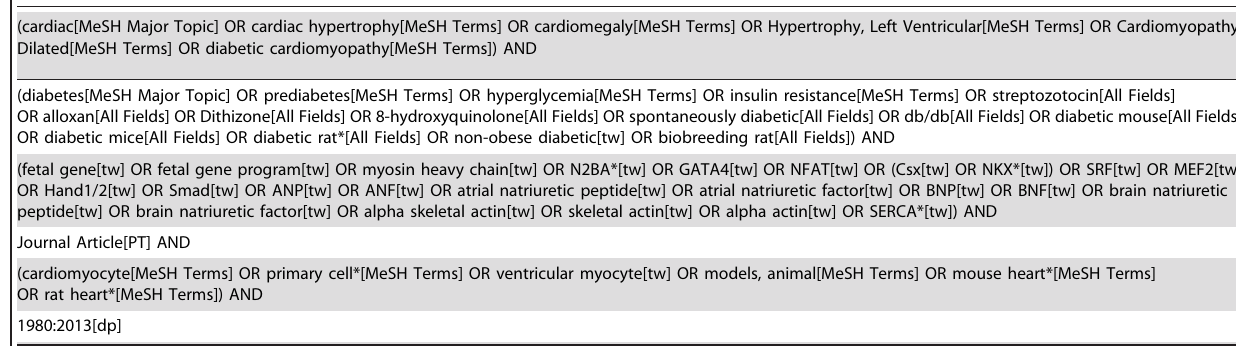
Table 1. Complete search terms used to collect articles from the PubMed database.